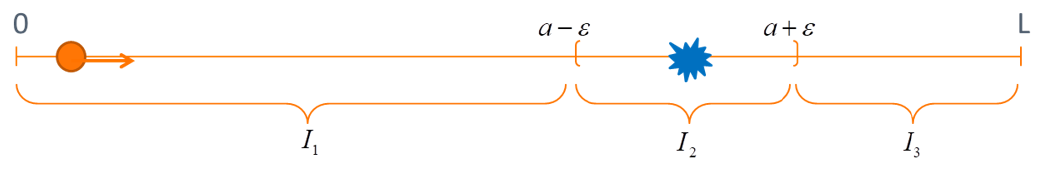
Fig. 1. Schematic presentation of the model system with one target